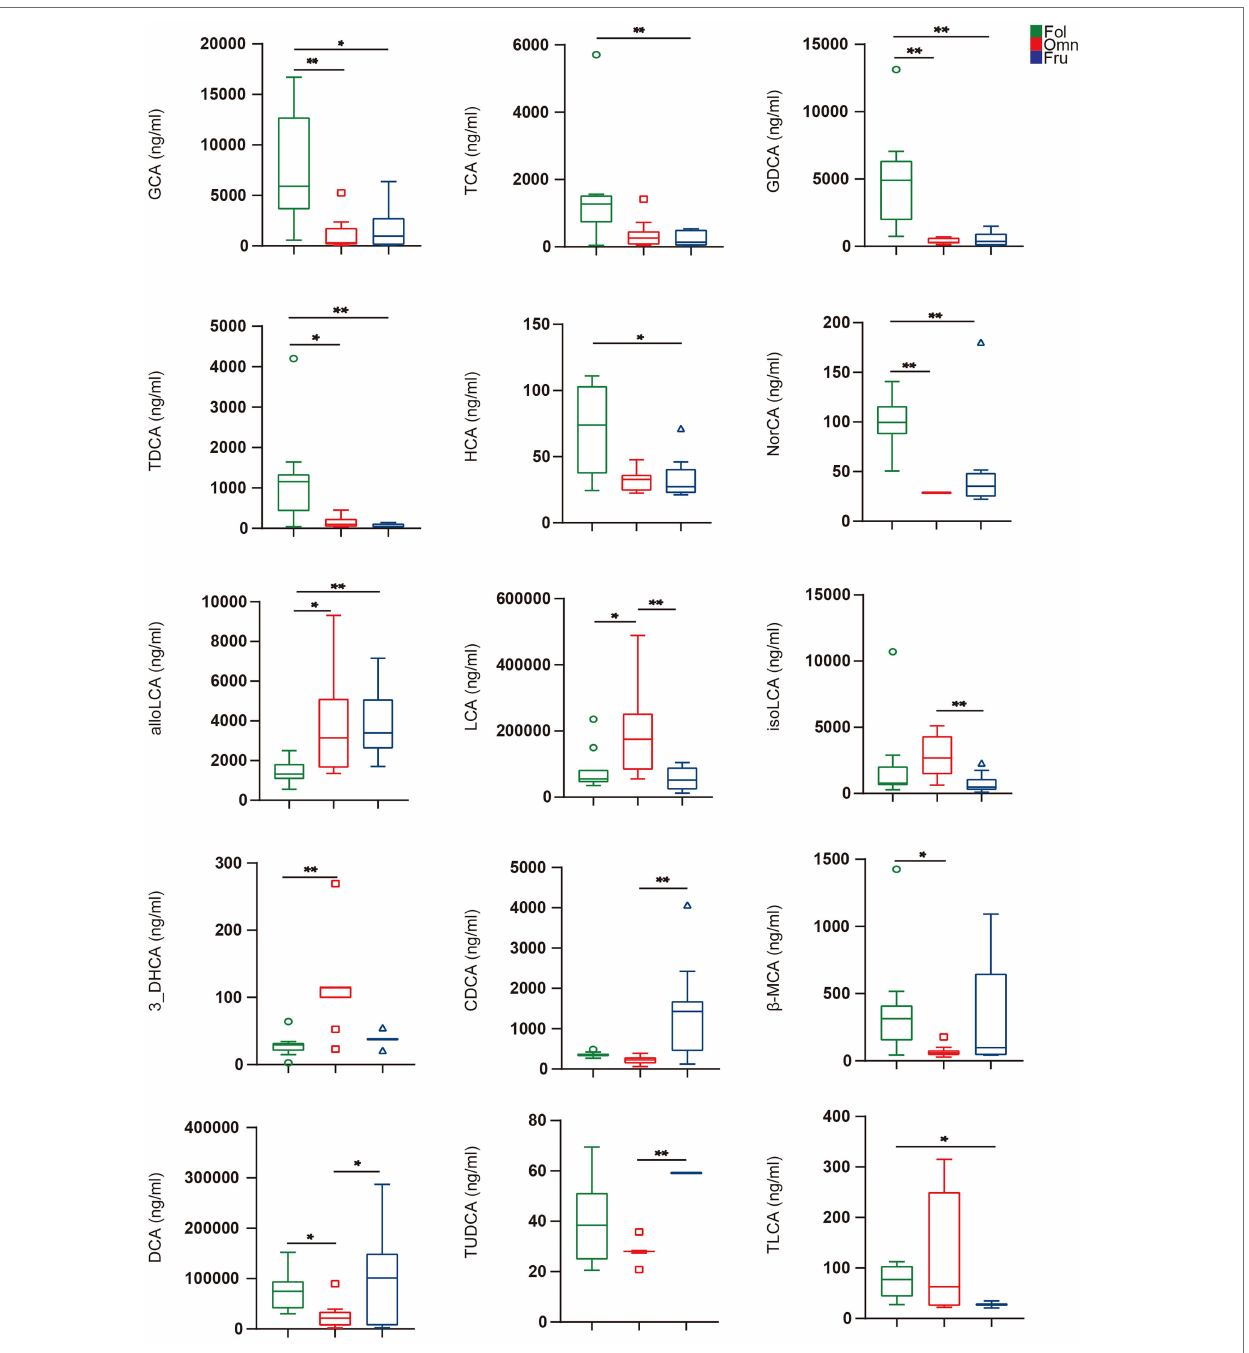
FIGURE 3 | Individual BAs amounts. BAs in feces were analyzed by the Kruskal–Wallis test with Dunn post hoc tests (for nonparametric unpaired data) using GraphPad Prism version 5.0. A value of p < 0.05 was considered statistically significant. * p < 0.05; ** p < 0.01. All data are shown in box-and-whisker plots according to